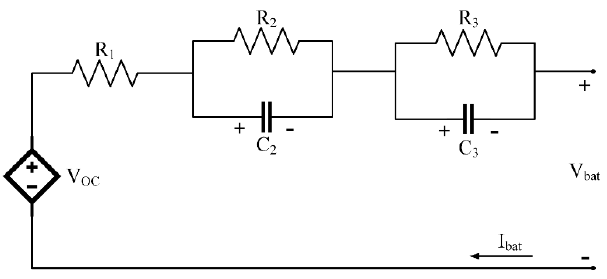
Figure 30. Equivalent circuit used for the simulation of the Li-polymer battery consisting of a resistor in series with two RC parallel branches [101].